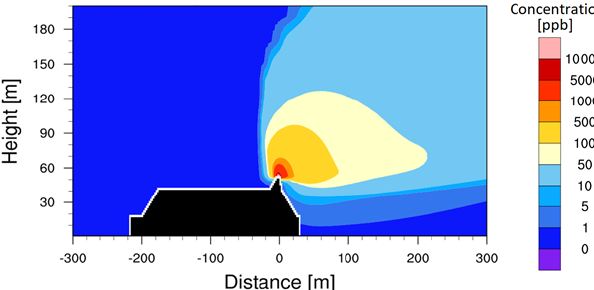
Figure 5. MITRAS model results for default conditions (frontal wind at 5ms − 1 , exit velocity 10ms − 1 , exhaust temper- ature of 300 ◦ C and an ambient temperature gradient of − 0.65K × 100m − 1